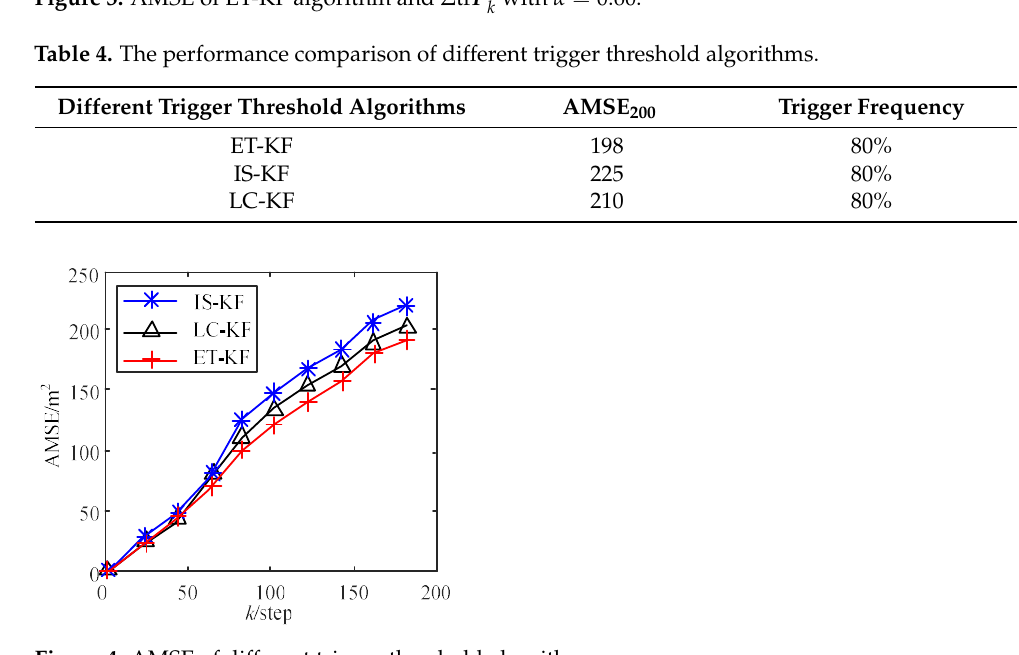
Figure 4. AMSE of different trigger threshold algorithms.